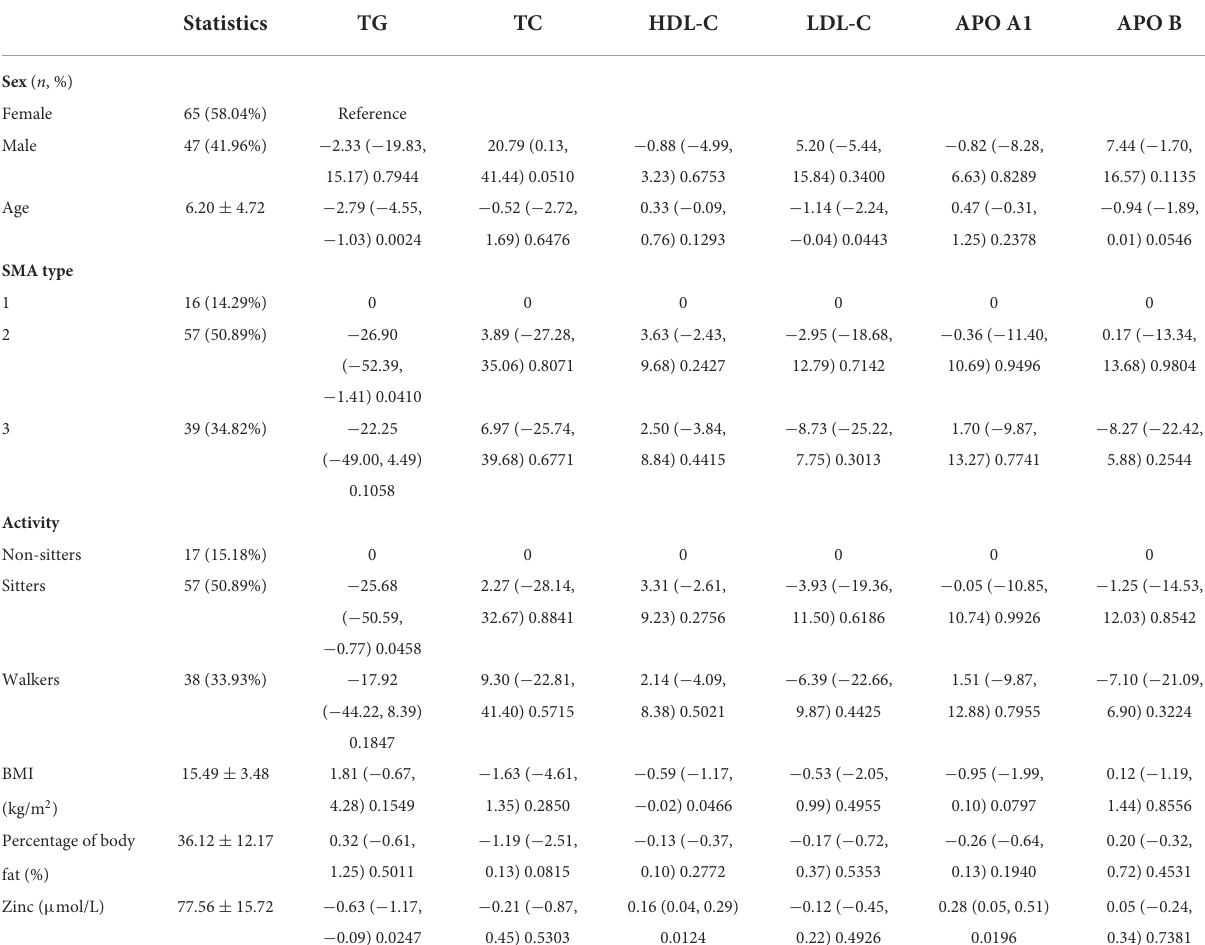
TABLE 2 Univariate analysis related to lipid